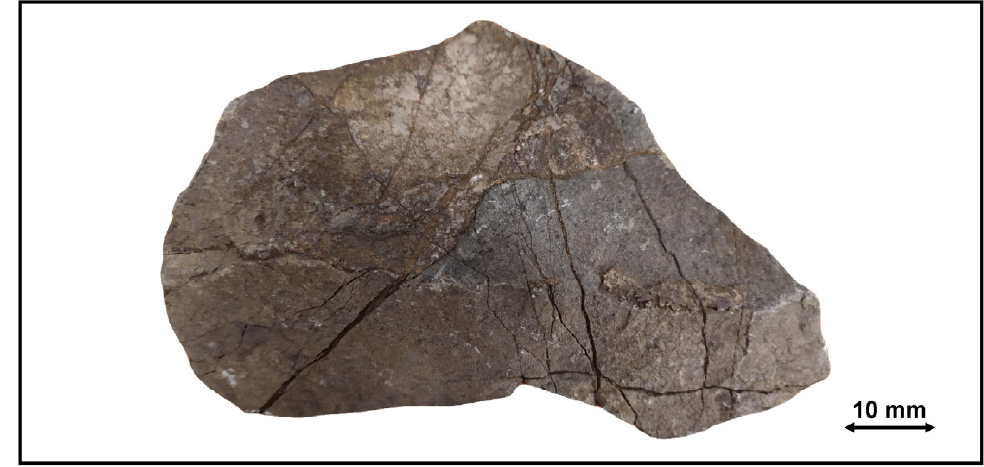
Figure 1. Sample of waste dump showing cracks filled with hydrothermal chemical compounds.